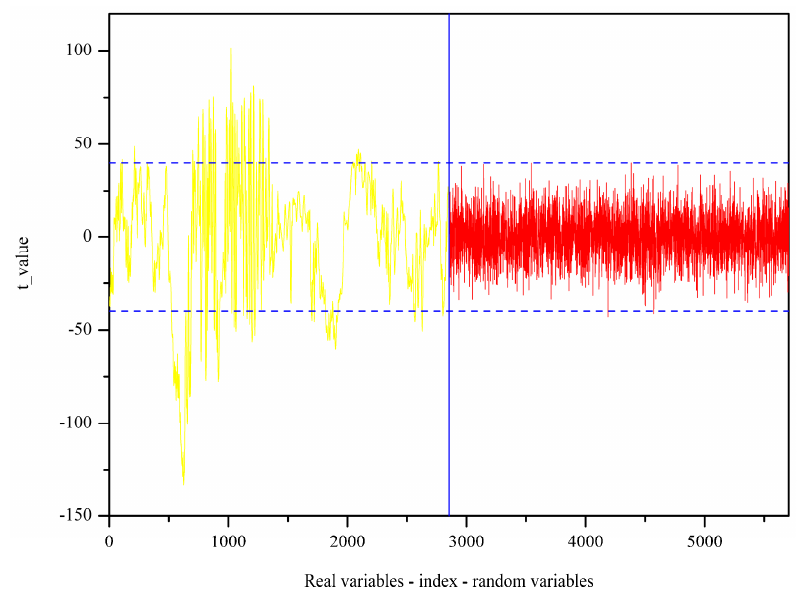
Figure 4. The stability of individual variables obtained by applying uninformative variable elimination (UVE).